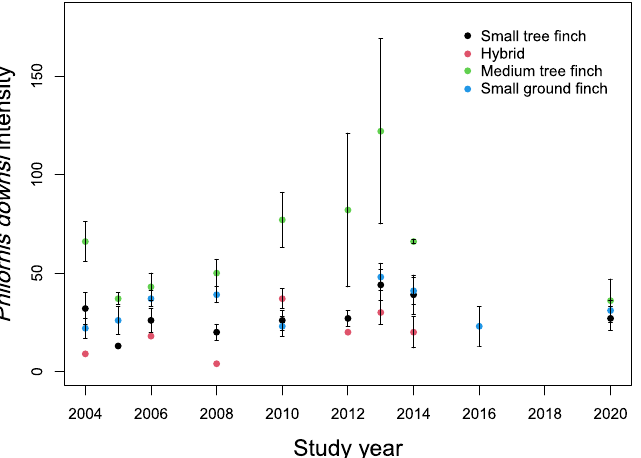
Figure 1. Number (mean ± SE) of avian vampire flies ( Philornis downsi ) per nest of Darwin’s finch species per year on Floreana Island. Each Darwin’s finch species is denoted by a different colour.